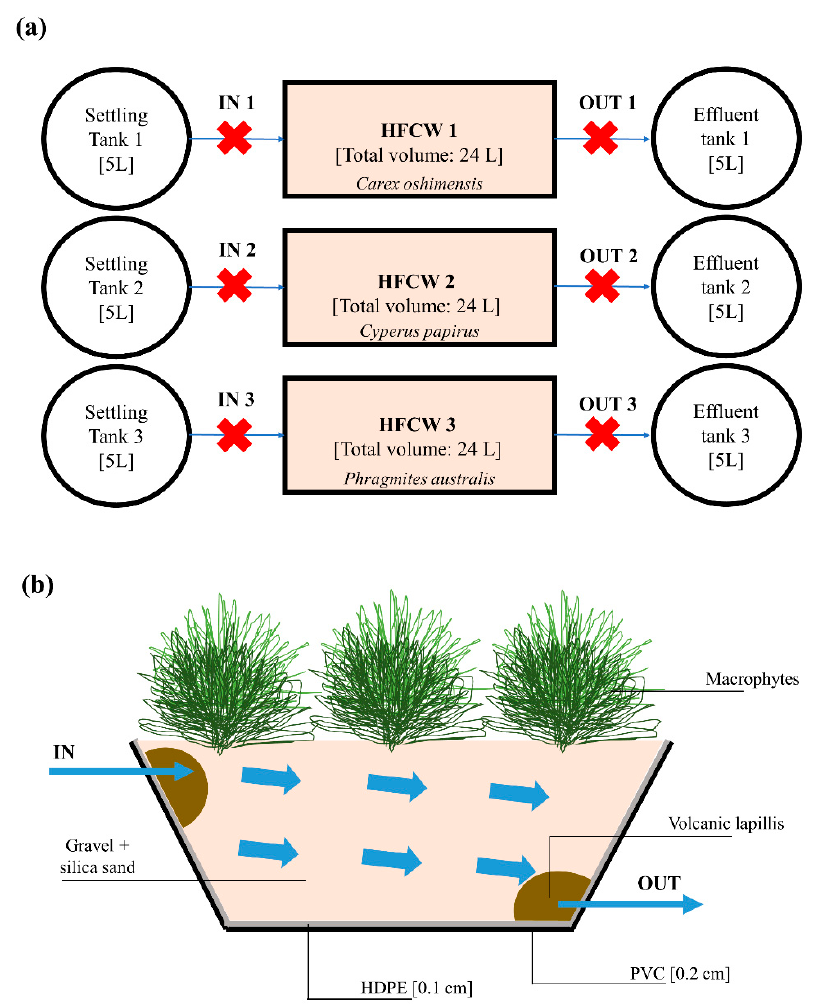
Figure 1. ( a ) Scheme of the preliminary laboratory-scale plant. The red crosses indicate the sampling points; ( b ) Side view of the horizontal flow constructed wetland (HFCW) laboratory-scale plant and pilot-scale plant. HDPE: high-density polyethylene, PVC: polyvinyl chloride. Each HFCW unit (with dimensions 0.6 m × 0.2 m × 0.2 m) had a volume of 24 L and was